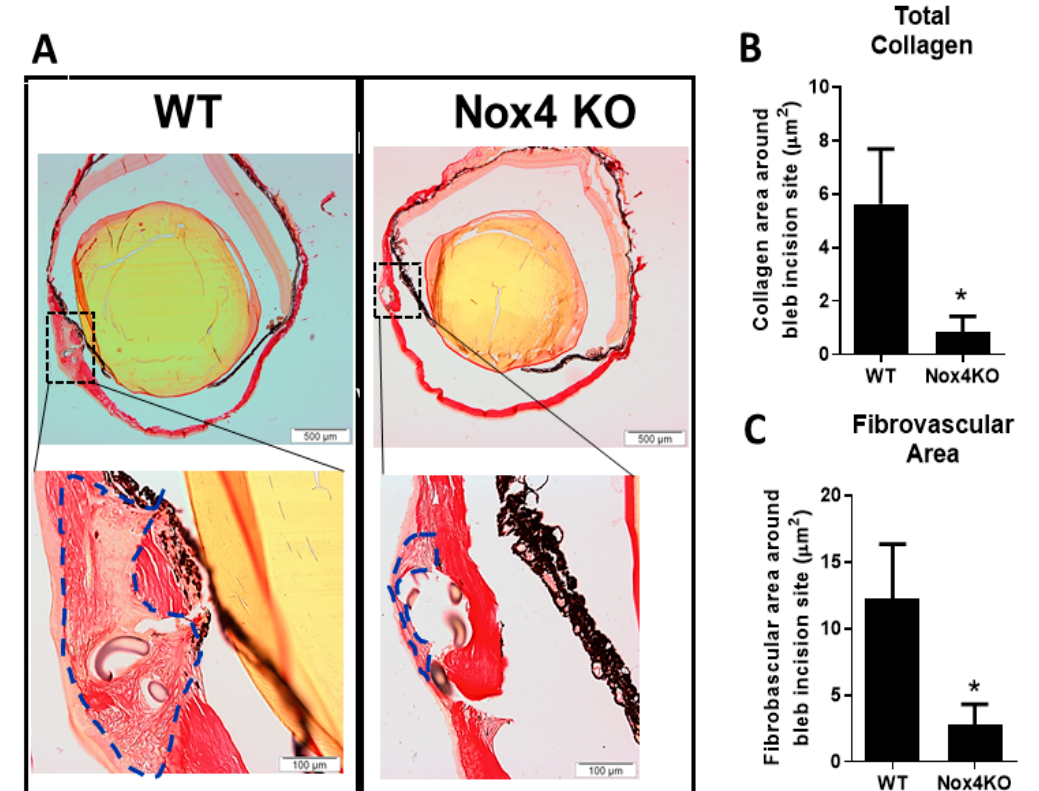
Figure 5. Reduced deposition of collagen at the wound in Nox4 knockout (KO) mice with glaucoma filtration surgery (GFS). ( A ) Representative images of eye cross sections from wildtype (WT) and Nox4 KO mice at 2 weeks after GFS. ( B ) A reduction in the area of both total collagen accumulation and ( C ) fibrovascularization at the wound is demonstrated in Nox4 KO mice. All data are mean ± SEM from four to five animals, * p < 0.05 from WT.